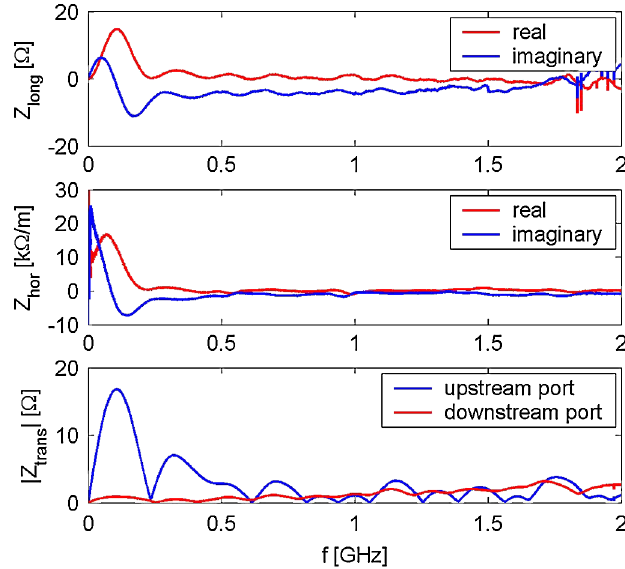
FIG. 11. Results of impedance measurements